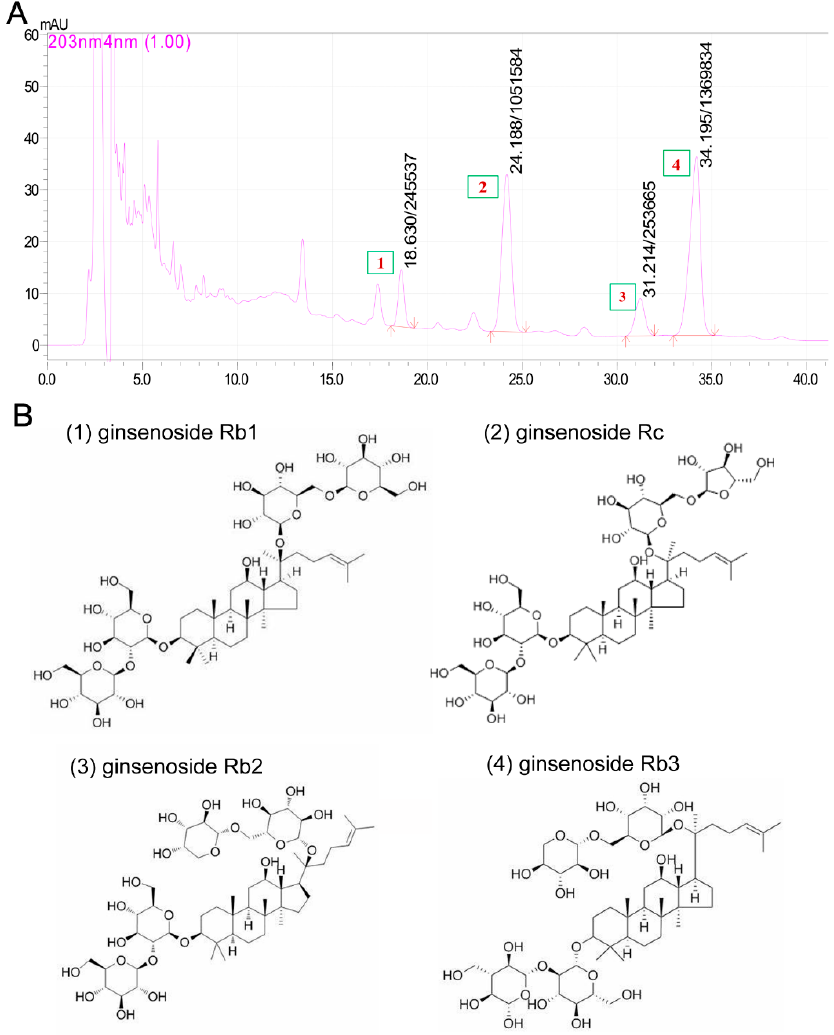
Figure 1. The chromatograms and chemical components of notoginseng leaf triterpenes (PNGL) used in experiments via the high performance liquid chromatography. ( A ) The chromatograms of PNGL samples. ( B ) Chemical component structures, mainly including ginsenoside Rb1 (No.1), ginsenoside Rb2 (No.3), ginsenoside Rb3 (No.4), and ginsenoside Rc (No.2).